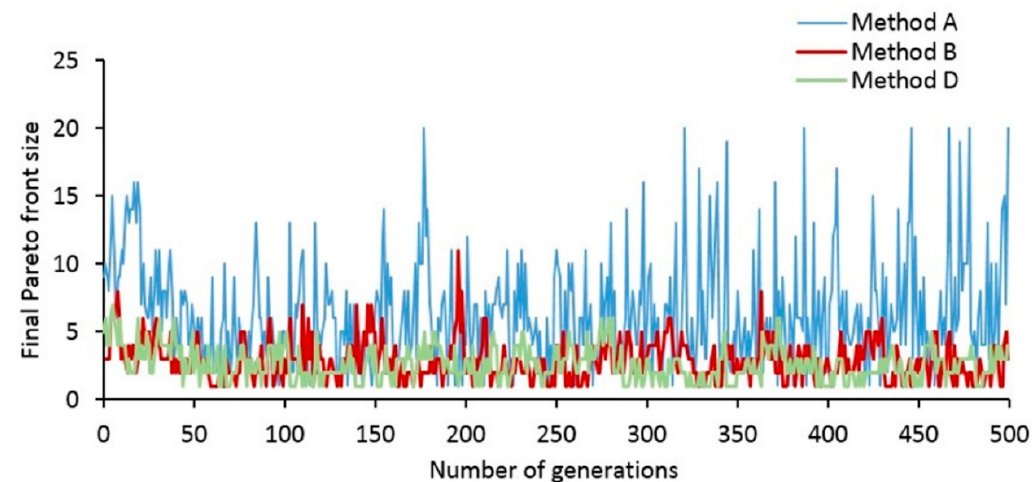
ISPRS Int. J. Geo-Inf. 2019 , 8 , x FOR PEER REVIEW Figure 8. The variation in final Pareto front size of three methods: A, B, and C.